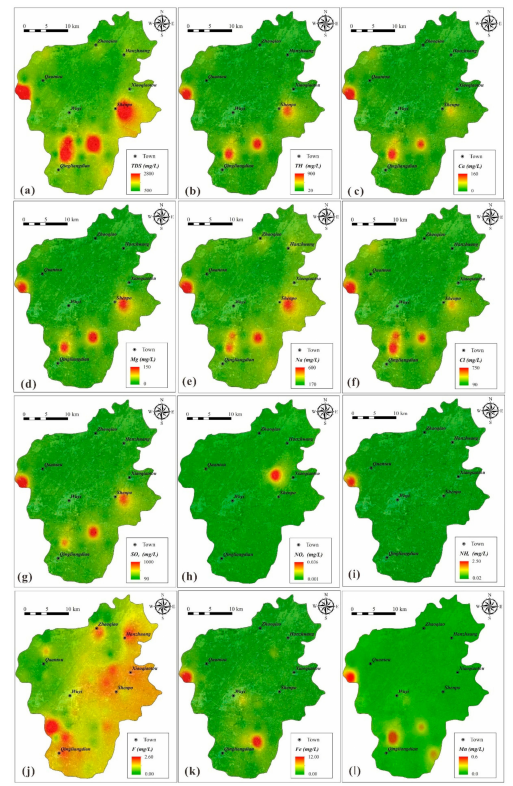
Figure 8. Spatial distribution of ( a ) TDS, ( b ) TH, ( c ) Ca 2 + , ( d ) Mg 2 + , ( e ) Na + , ( f ) Cl − , ( g ) SO 42 − , ( h ) NO 2 − , ( i ) NH 4 + , ( j ) F − , ( k ) Fe, and ( l ) Mn in